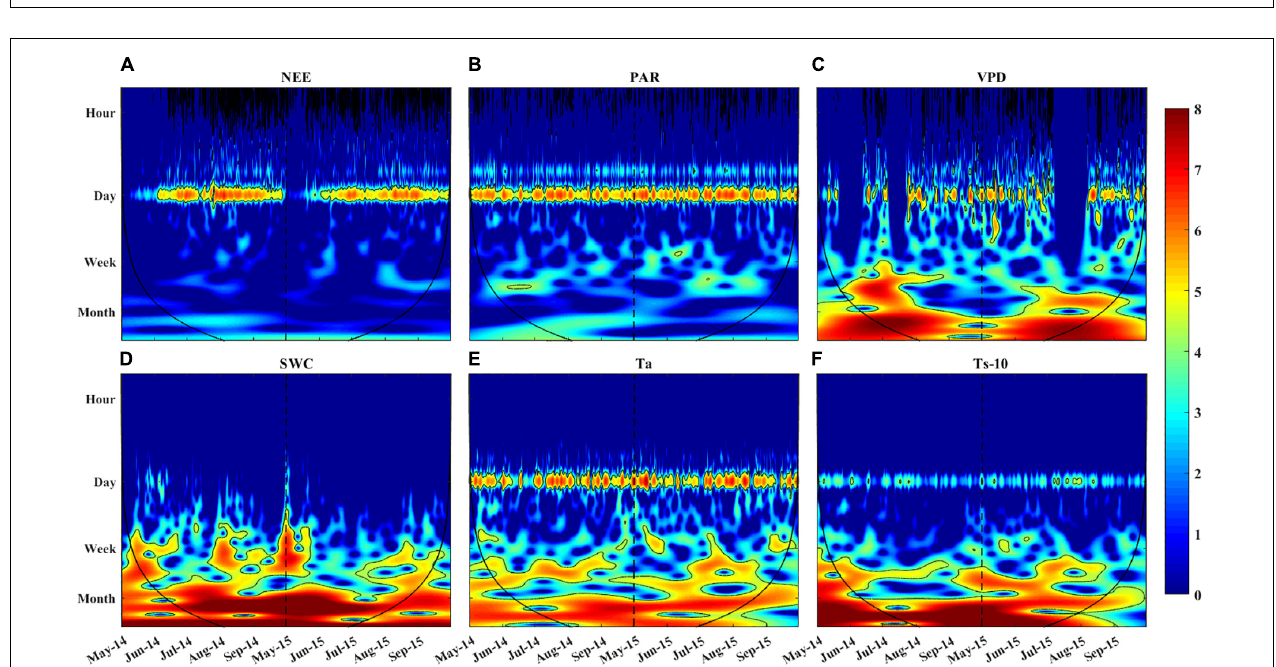
FIGURE 7 | Wavelet power spectrum for (A) NEE, (B) PAR, (C) VPD, (D) SWC, (E) Ta, and (F) Ts-10 during the growing season in 2014 and 2015. The black line represents the cone of influence, beyond which edge effects are abundant and thus the results should be interpreted with caution. The color codes for power values are from dark blue (low values) to dark red (high values). The dotted line is used to distinguish the growing season of 2014 and 2015.